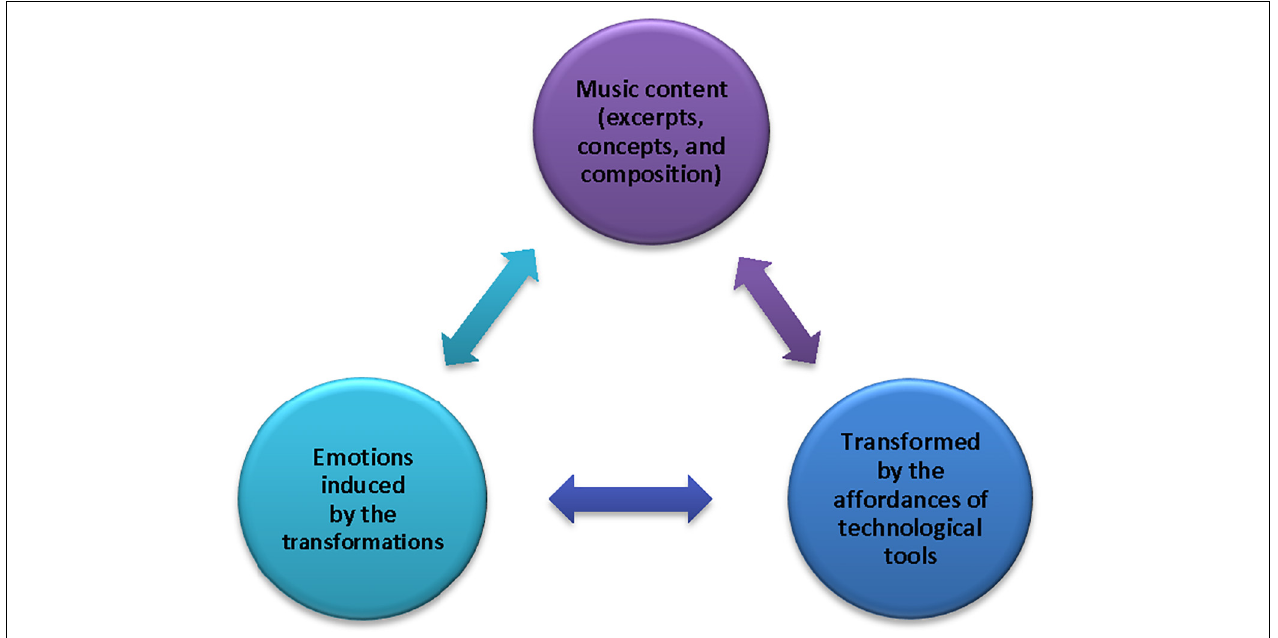
FIGURE 4 | Interactions among musical content, emotions, and technology (adopted from Macrides and Angeli,